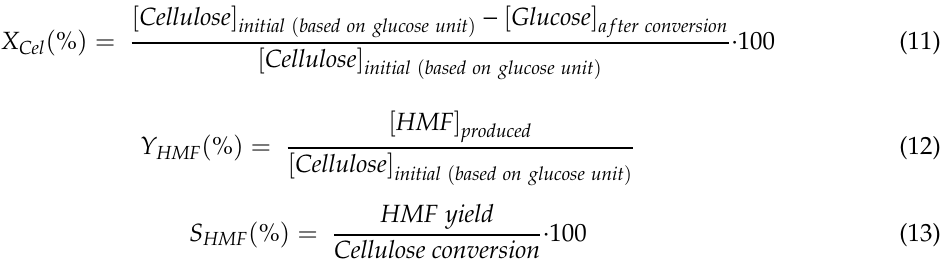
Bibliometric analysis and kinetic study results. Figure S1: Number of documents published per year referring to the occurrence of the term “Hydroxymethylfurfural” in studies from 2011 to 2020. Bibliometric analysis was carried out on the Scopus search platform on 23 June 2020. Table S1: Search criteria and number of documents found in the bibliometric analysis of the Scopus search platform on 23 June 2020. Table S2: Cellulose concentration (mol / L) and conversion (%), HMF concentration (mol / L e g / L) and yield (%) obtained in the HMF production from cellulose at 180 and 200 ◦ C with time ranging from 10 to 60